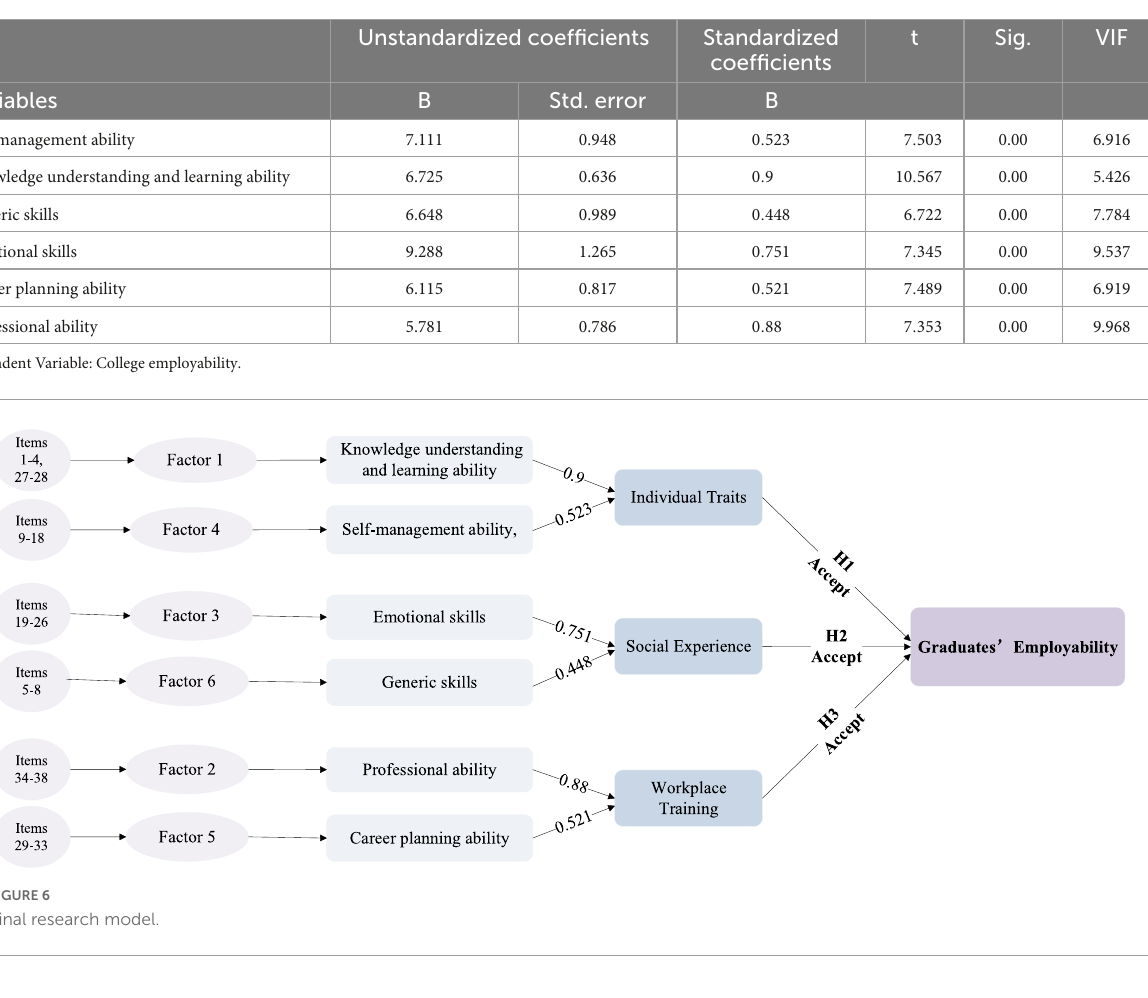
TABLE 8 Multiple linear regression.